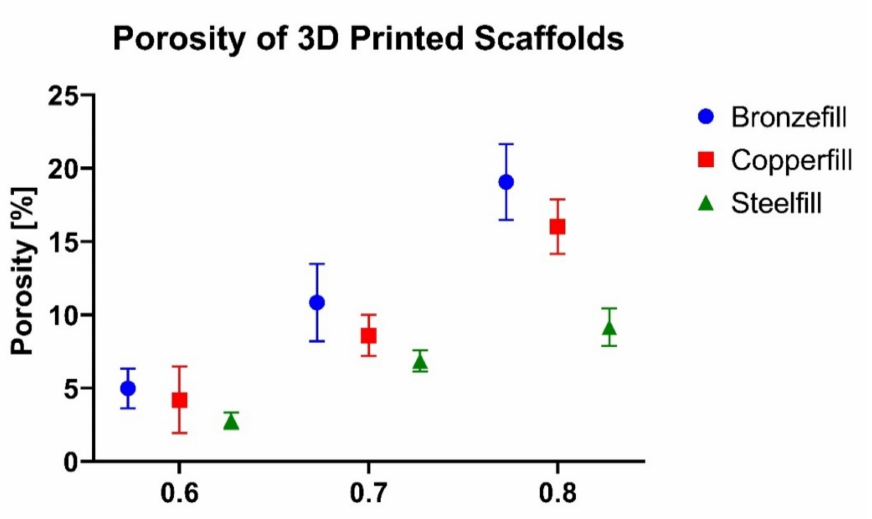
Figure 4. Porosity of the 3D printed scaffolds: bronze-filled, copper-filled and steel-filled. N =